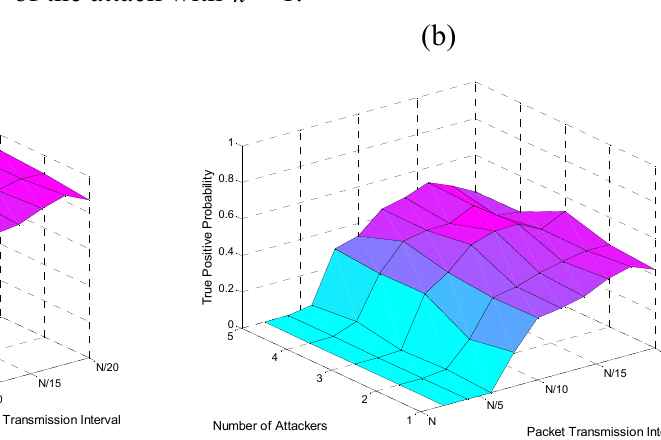
Figure 11. (a) True positive probability with increasing number of attackers and increasing intensity of the attack with ˆ k = 0.5. (b)True positive probability with increasing number of attackers and increasing intensity of the attack with ˆ k =